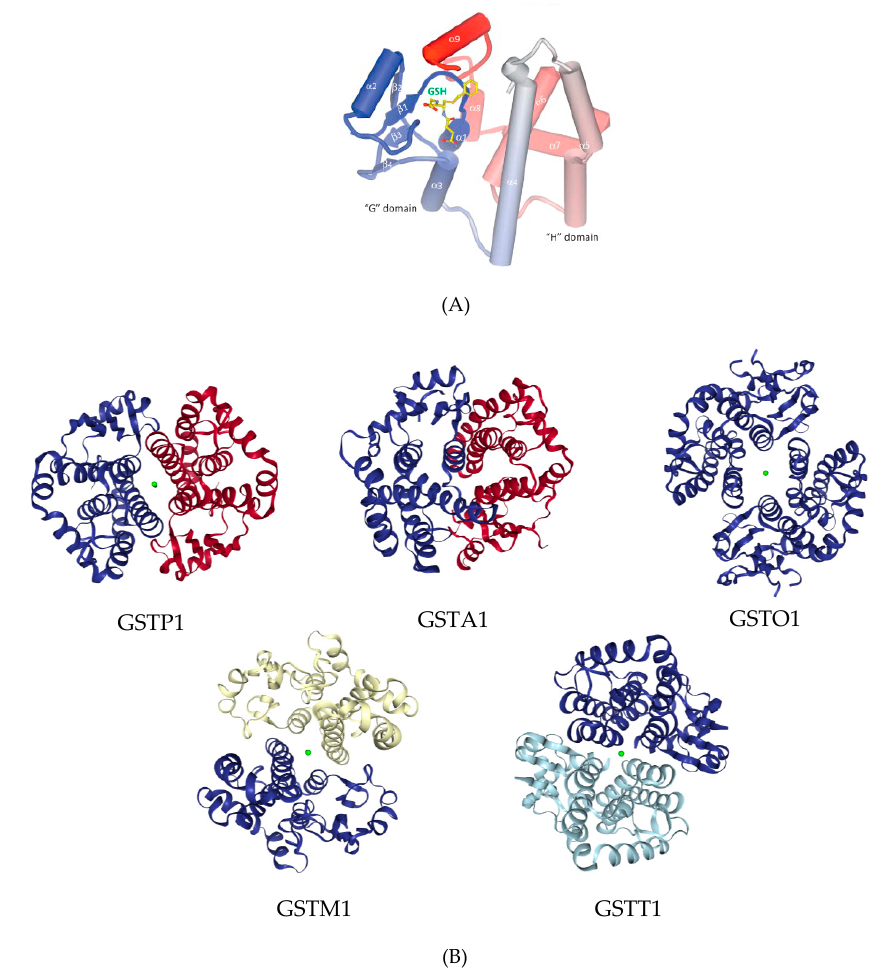
Figure 1. Glutathione transferases (GST) structure variability among classes: ( A ) Tertiary structure of GST enzyme, consisting of “G” domain for glutathione (GSH) binding, and “H” domain for hydrophobic substrates, adopted from Wu et al . [7], with the permission by Elsevier Ltd (Copyright 2012); ( B ) Crystal structures of human GSTs, adopted Protein Data Bank.